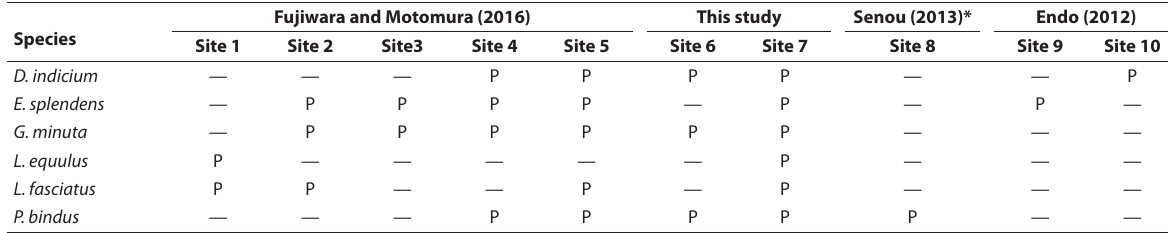
Table 1. Distribution records (P, present; —, absent) of six tropical species of Leiognathidae defined by Nakabo (2013) and their literature source. Number of each site (1–10) corresponding with site numbers in Figure 1 Fujiwara and Motomura (2016) Species D. indicium E. splendens